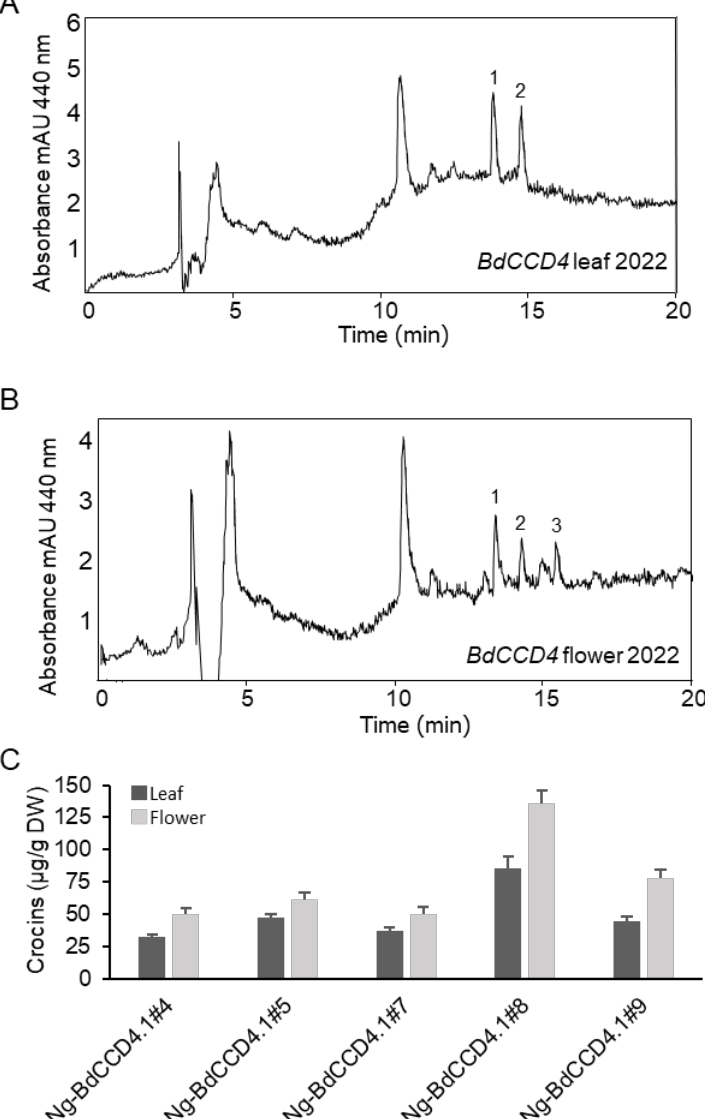
Figure 5. Accumulation of crocins in the Wt and transgenic T1 lines of Nicotiana glauca constitu- tively expressing BdCCD4.1. ( A ) HPLC-DAD analysis of polar extracts from Wt and N. glauca leaves at 440 nm. ( B ) HPLC-DAD analysis of polar extracts from transgenic and Wt N. glauca petals at 440 nm. Peaks for the abundant crocins in the transgenic lines are denoted by numbers in leaves (1 = trans-crocin 2; 2 = trans-crocin 1) and in petals (1 = trans-crocin 2; 2 = trans-crocin 1; 3 = cis-crocin 2). Crocins were completely absent from the Wt plants. mAU, milli-absorbance units. ( C ) Apocarotenoid accumulation in leaves and petals of transgenic lines. Analyses were done in triplicate. Error bars represent the SD. DW, dry weight.